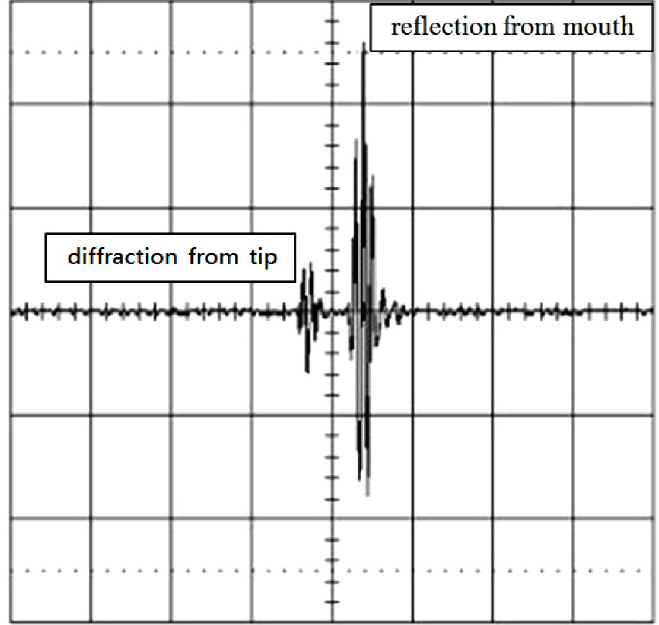
Figure 2. Reflection waves from the surface